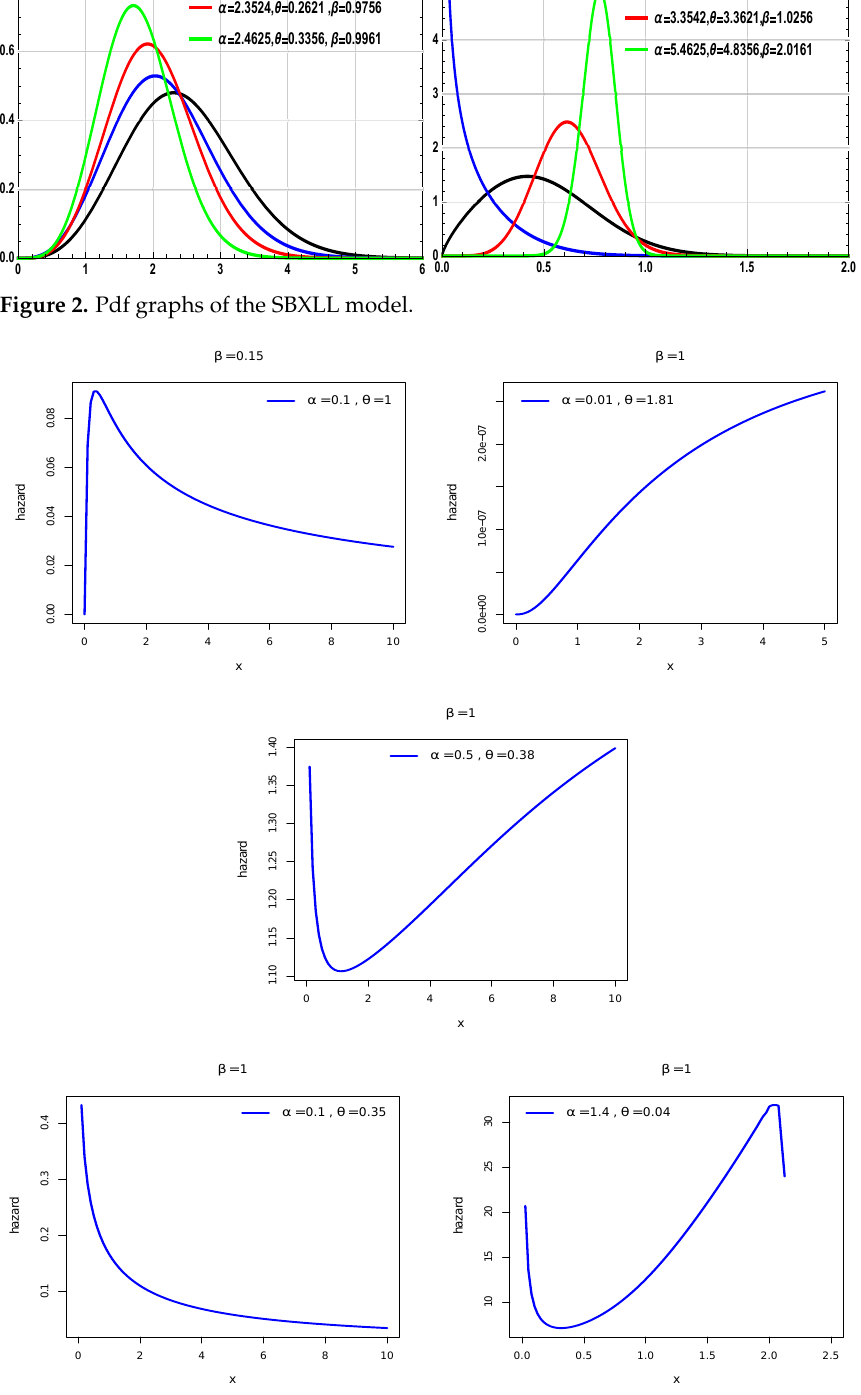
Figure 3. Plots of hrf of the SBXL model for random parameter